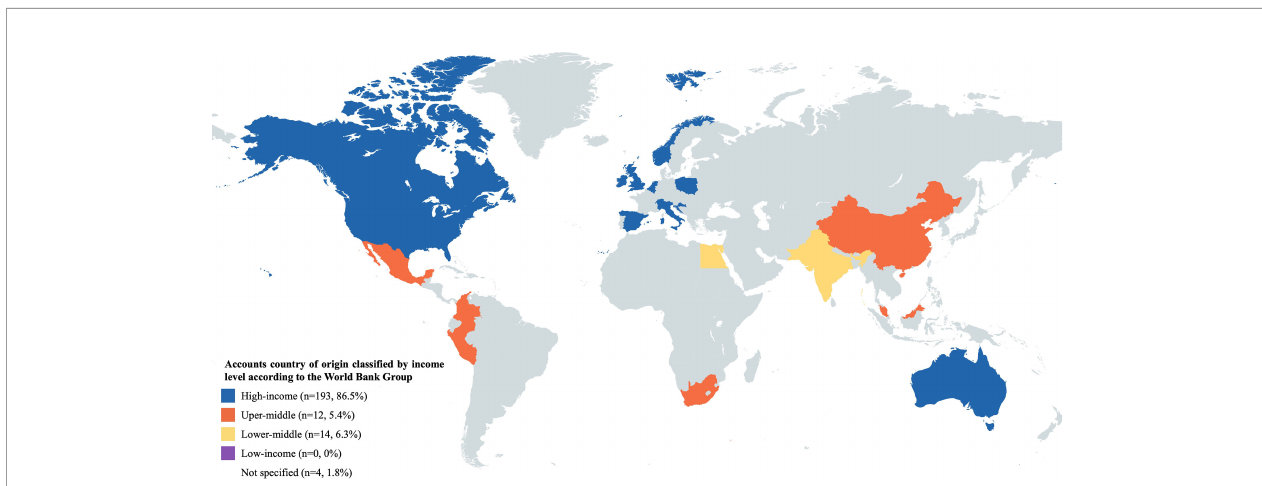
FIGURE 1 | Country of origin of Twitter accounts of participants in OF and FP tweets classi fi ed by income level according to the World Bank